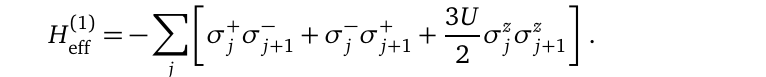
Figure 14: Finite-size scaling of the energy gaps ∆ Ising antiferromagnetic (a) as well as the Ising ferromagnetic (b) phase. Both DMRG results are for system sizes L = 64,65,...,100. In both cases we find ∆ ing that the ground states are two-fold degenerate, while ∆ namic